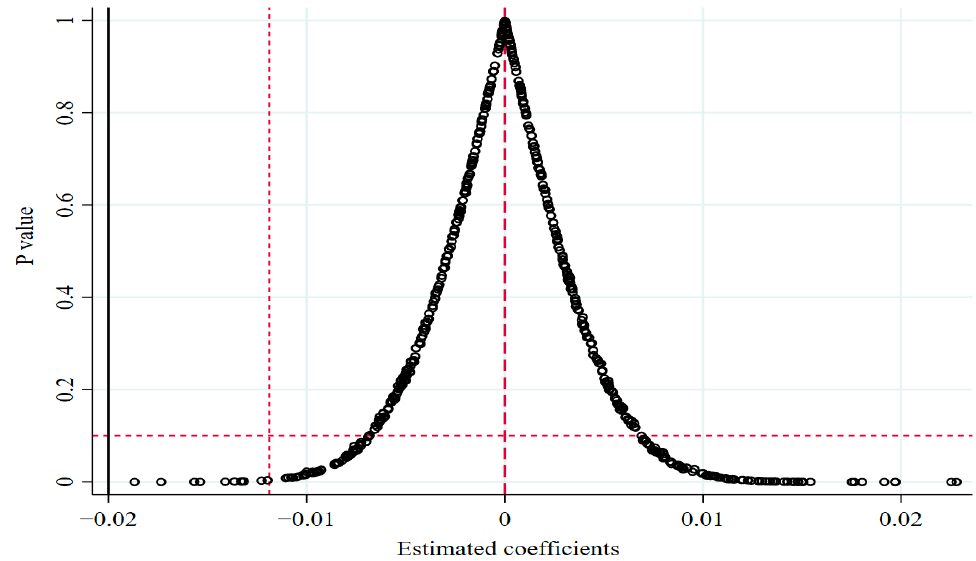
Figure 2. Distribution of estimated coe ffi cients after random processing (500 samples). Note: the X -axis is the estimated coe ffi cients generated randomly 500 times, the empty circle is the P-value of the estimated coe ffi cients, and the left vertical line is the estimated coe ffi cient of the actual pol- icy.